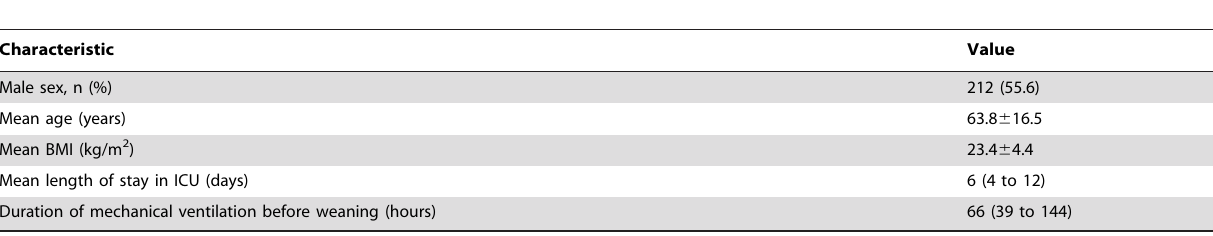
Table 1. Patient Demographic and Clinical Characteristics.